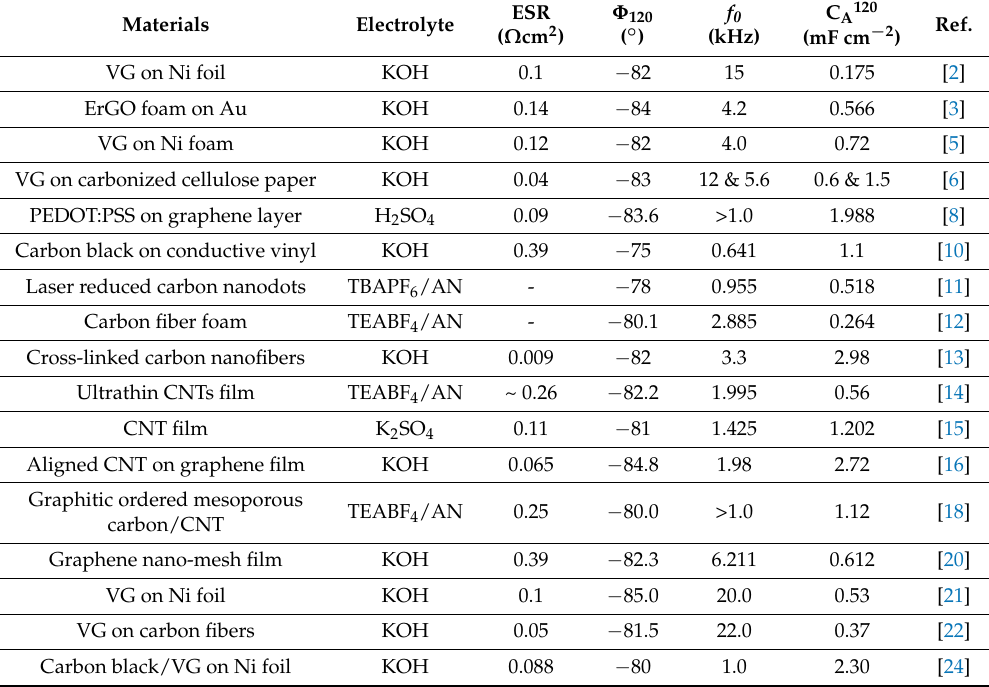
Table 1. Comparison of different carbon-based materials for HF-ECs in terms of equivalent serial resistance (ESR), phase angle ( Φ 120 ), and single electrode areal capacitance (C A120 ) at 120 Hz, characteristic frequency ( f 0 ) and type of